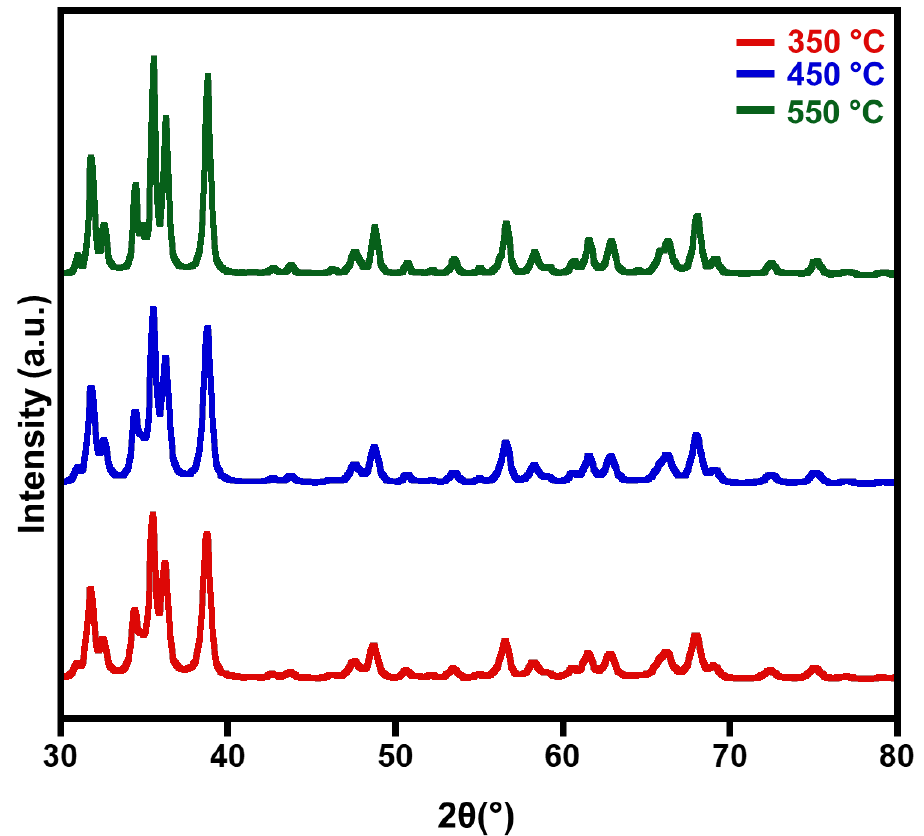
Figure 1. XRD patterns of Cu x Zn y O mixed metal oxide nanoparticles calcined at 350, 450, and 550 °C.